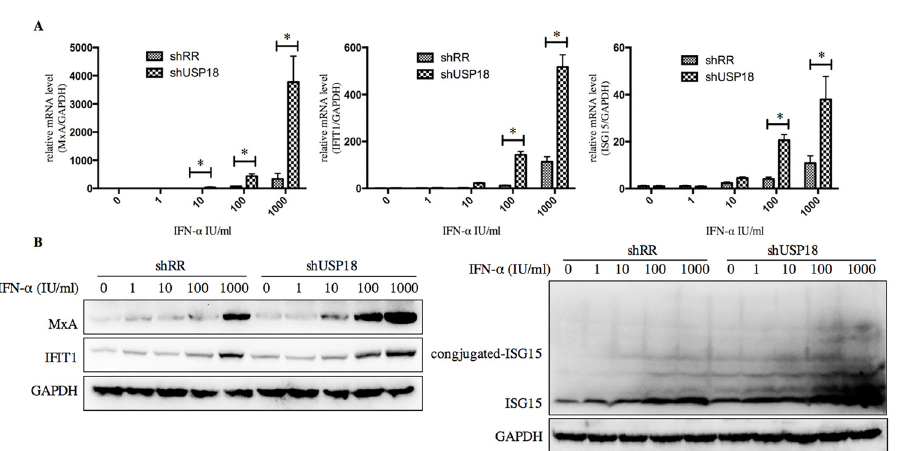
Fig 5. Inhibition of USP18 gene expression in Hepg2.2.15 cells by shUSP18-1 lentivirus increases the antiviral activity of IFN- α . Hepg2.2.15 cells were treated with indicated concentration of IFN- α (0, 1, 10, 100, 1000 IU/ml) for 24 hours after either shUSP18 or shRR lentivirus transduction. (A) and (B) The mRNA and protein levels of ISGs such as ISG15, MxA and IFIT1 were quantified by real-time PCR and western blot separately. The results are presented as the means ± SD, n = 3, error bars indicate SD. * P < 0.05; ** P < 0.01 vs. control.